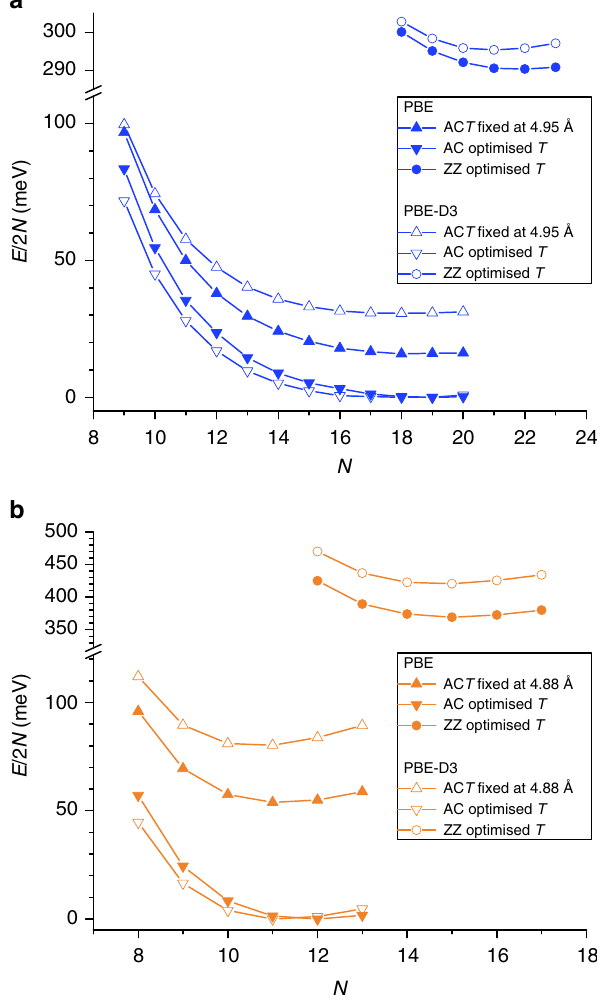
Fig. 7 Energy per imogolite unit for methylated nanotubes with different chiralities. Computed E /2 N pro fi les for AC and ZZ GeCH 3 ( a ) and SiCH 3 ( b ) nanotubes at PBE ( fi lled symbol) and PBE-D3 (hollow symbol) level. AC traces have been computed for both the experimentally fi tted and DFT- optimized NT-periods. ZZ traces are displayed only for DFT-optimized periods